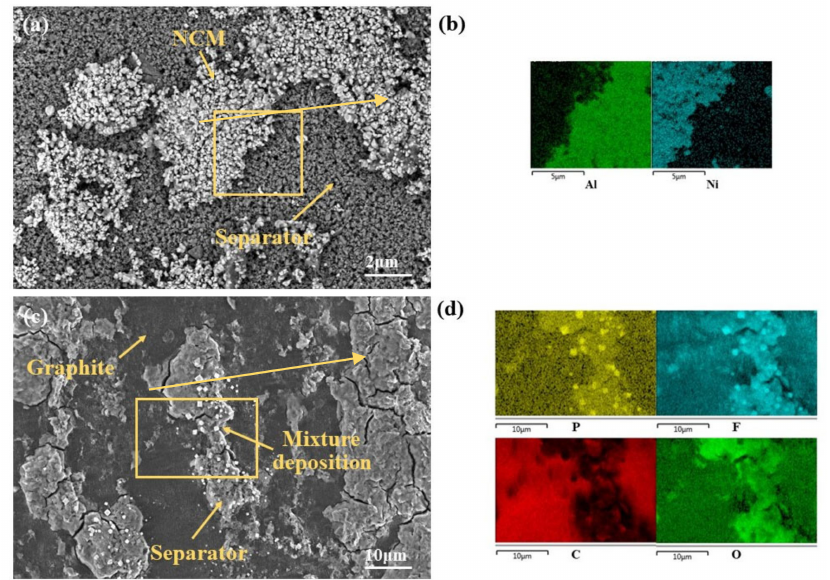
Figure 10. SEM micrographs of electrodes from the disassembled battery ( a ) obtained from the separator facing the positive electrode, ( b ) the EDS diagram of the marked part from ( a ). ( c ) Obtained from the separator facing the negative electrode, ( d ) the EDS diagram of the marked part from ( c